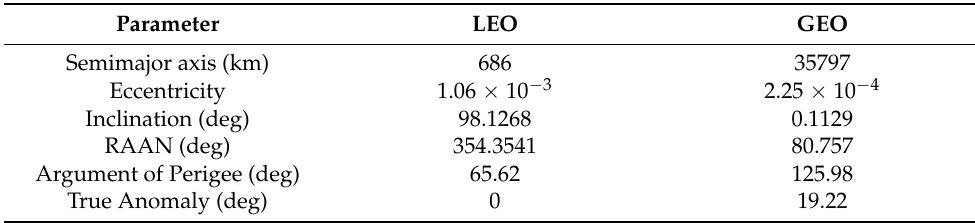
Table 3. Satellite TLE